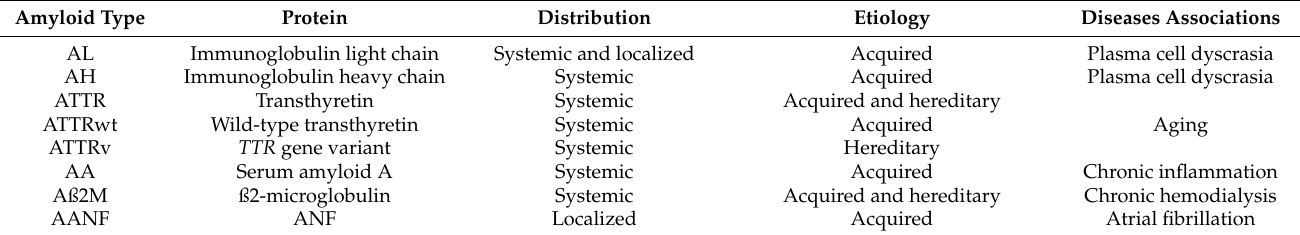
Table 1. Some forms of cardiac